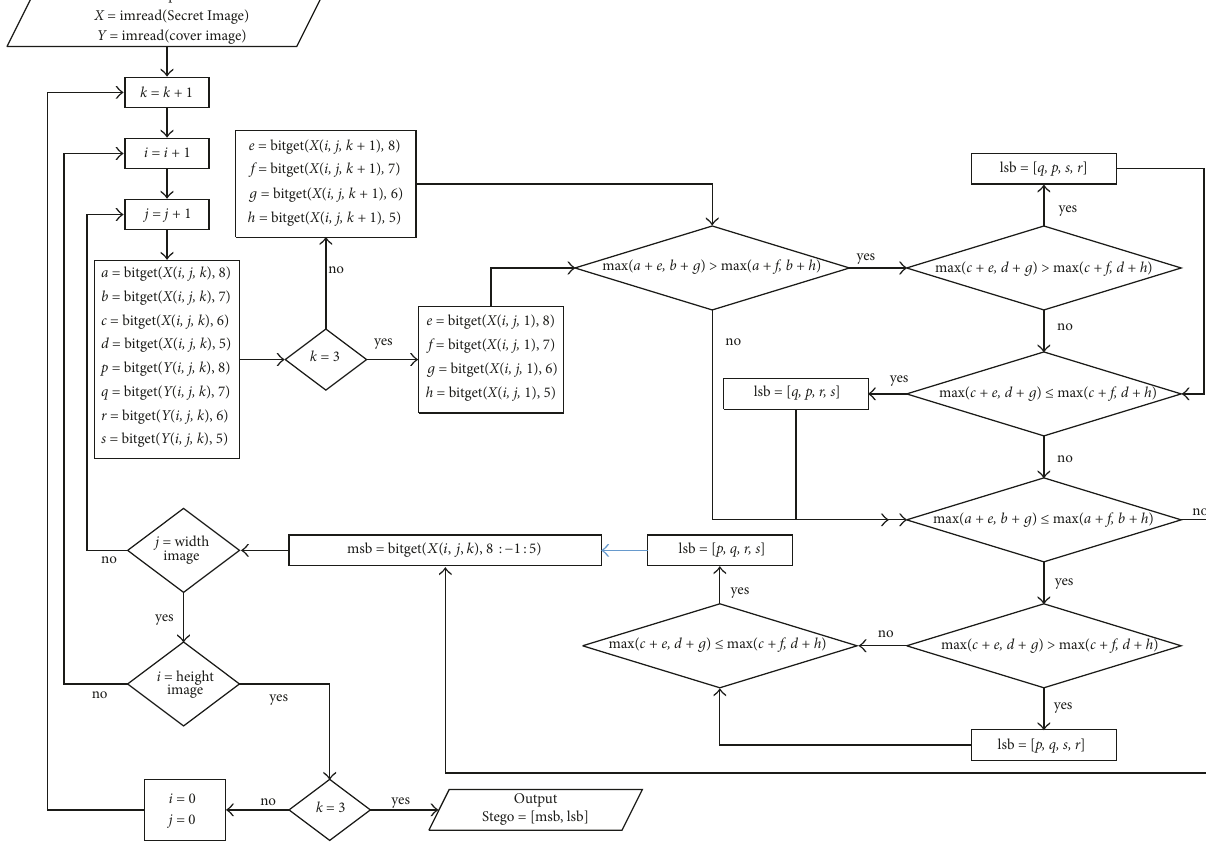
Figure 3: Flowcharts to hide the secret image into the cover image.